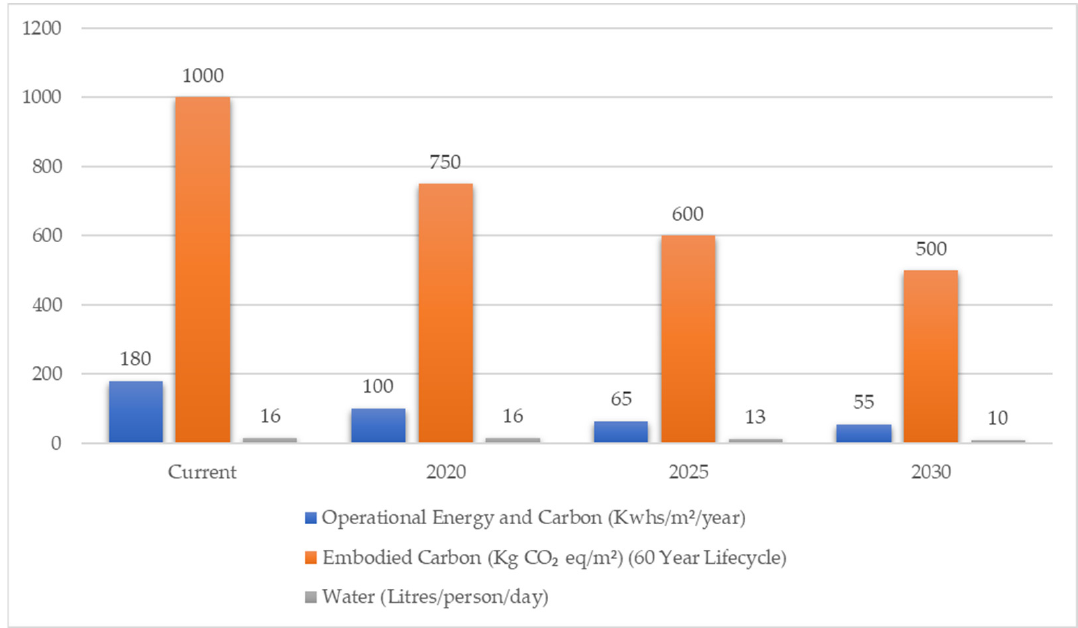
Figure 3. Organisation D’s pathway to net-zero carbon design (Source: Organisation D).